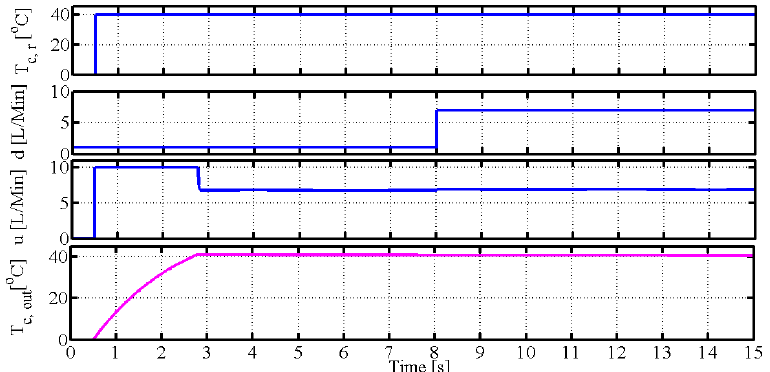
Figure 14. Simulation of FOPID without operator.